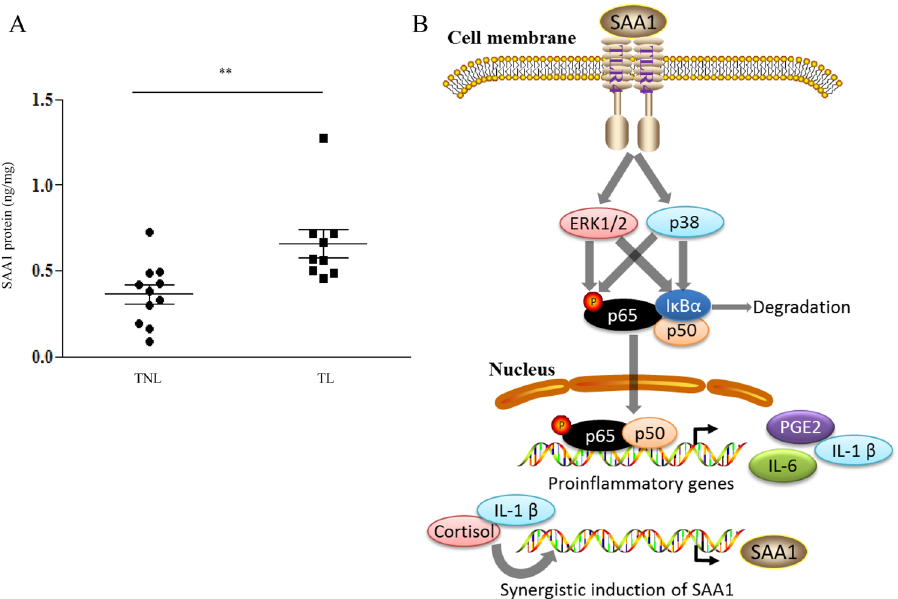
Figure 8. ( A ) Changes of SAA1 protein abundance in the amnion tissue following spontaneous labor. Abundance of SAA1 in human amnion tissue collected at term after spontaneous labor (TL) (n = 9) and after elective Cesarean section without labor (TNL) (n = 11). Data are the means ± SEM. Statistical analysis was performed with un-paired Student’s t-test. ** P < 0.01 or TNL. ( B ) Signaling pathways uncovered in this